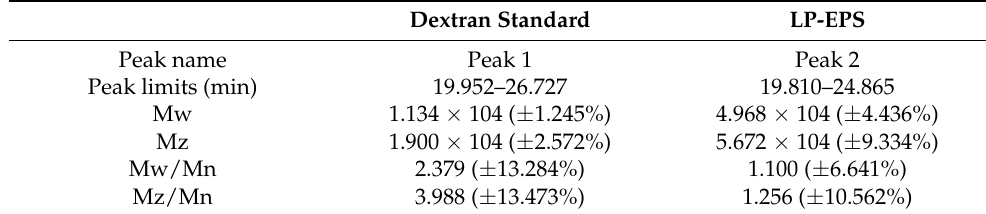
Figure 2. Molecular characterization of LP-EPS: ( a ) GPC chromatogram of dextran standard; ( b ) GPC chromatogram of LP-EPS; ( c ) SEM image of LP-EPS (250 × ); ( d ) SEM image of LP-EPS (500 × ); ( e ) SEM image of LP-EPS (750 × ); ( f ) SEM image of LP-EPS (1000 × ); ( g ) AFM image of LP-EPS; ( h ) TGA analysis of LP-EPS. Table 2. LP-EPS molecular weight